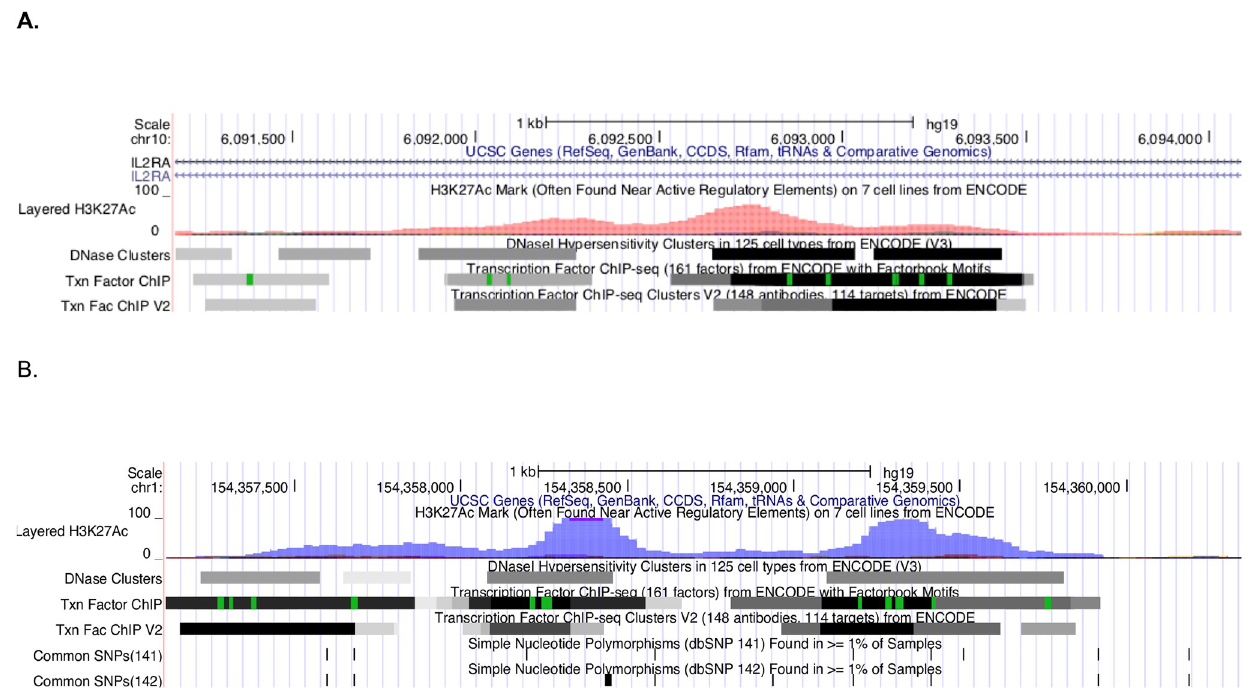
Fig 2. UCSC genome browser view of a select region within the IL2RA haplotype within the first intron of the IL2RA (A) gene and a select region within the IL6R haplotype (B). These regions are characterized by dense H3K27ac histone peaks (shown as magenta/purple peaks-ENCODE and Roadmap Epigenomics data). The black and gray horizontal lines represent DNAse hypersensitive sites and TF binding from ChIPseq data (also from ENCODE and Roadmap Epigenomics data). Identical chromatin features are seen in this region in both human CD4+ T cells and